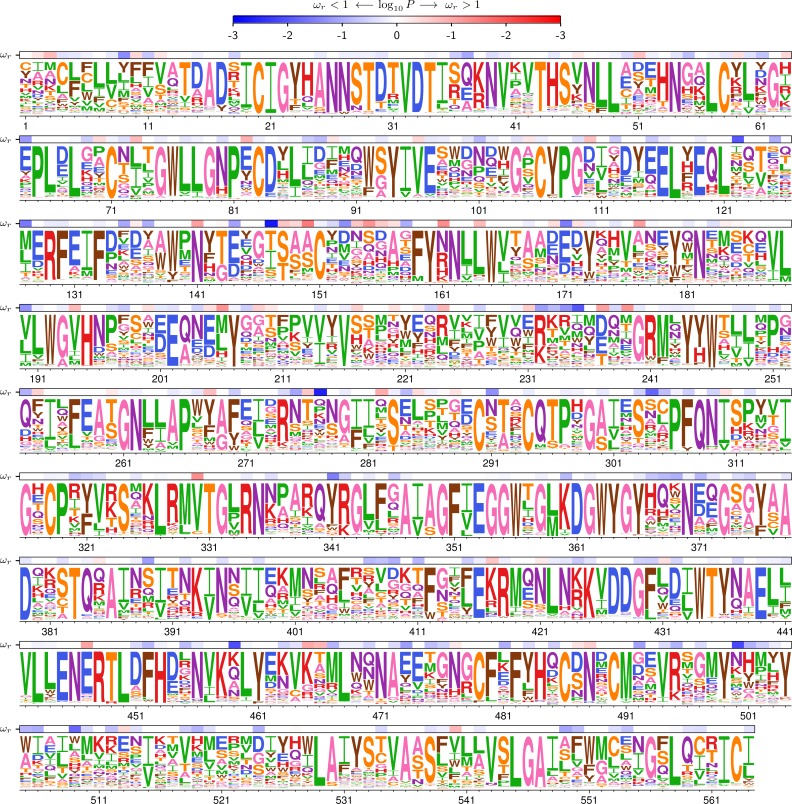
Identifying sites of diversifying selection.The phydms option –omegabysite fits a site-specific value for ωr, which gives the relative rate of non-synonymous to synonymous substitutions at site r after accounting for the selection due to the amino-acid preferences. This figure shows the results of such an analysis for HA. The overlay bar represents the strength of evidence for ωr being greater (red) or less (blue) than one. Because this approach accounts for the constraints due to the amino-acid preferences, it can identify sites evolving faster than expected even if their absolute relative rates of nonysnonymous to synonymous substitutions do not significantly differ from one. The logoplot in this figure uses the stringency parameter value of β = 2.11, and was generated by running the following command on the data in File S3: phydms_logoplot results/omegabysite.pdf –prefs HA_Doud_prefs.csv –omegabysite results/omegabysite.txt –stringency 2.11 –minP 0.001. In this figure, the HA sequence is numbered sequentially beginning with 1 for the first site with deep mutational scanning data, which is the second residue in the protein.